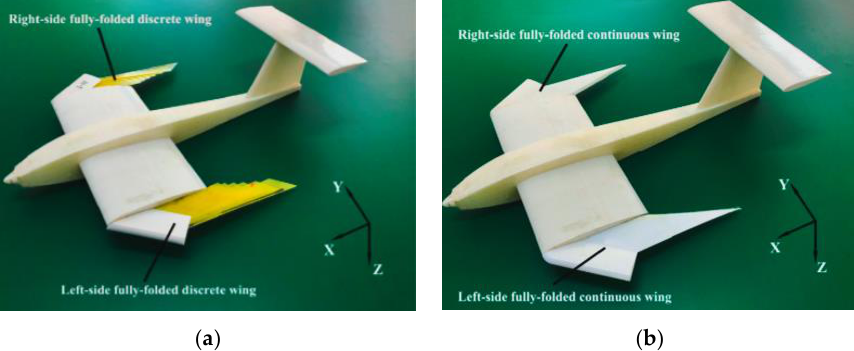
Figure 20. Models fabricated for wind tunnel testing ( a ) Completely folded, discrete wing design ( b ) Completely folded, continuous wing design [72].